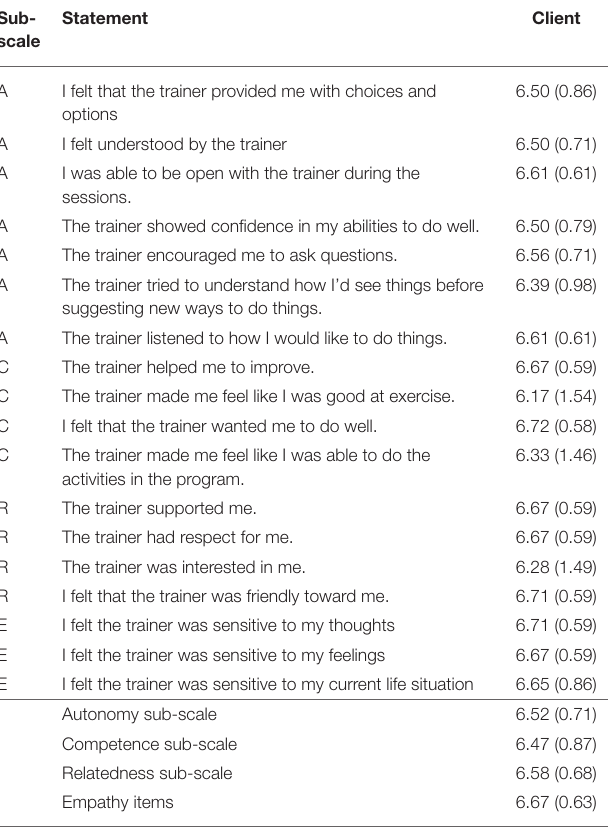
TABLE 4 | The mean and standard deviation for client responses to the learning climate